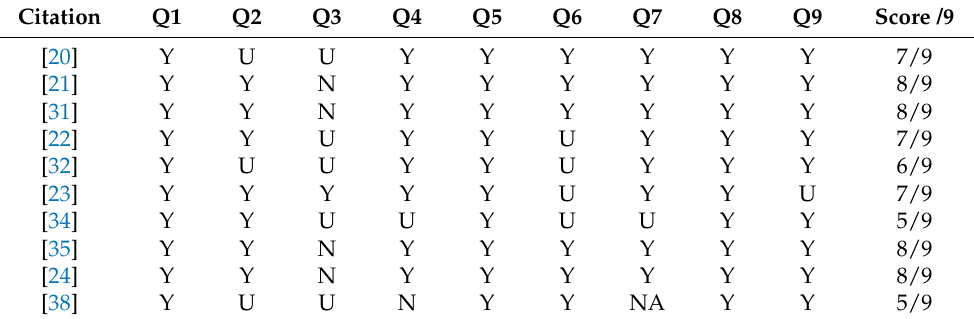
Table 1. JBI Critical Appraisal Checklist for Quasi-experimental studies.